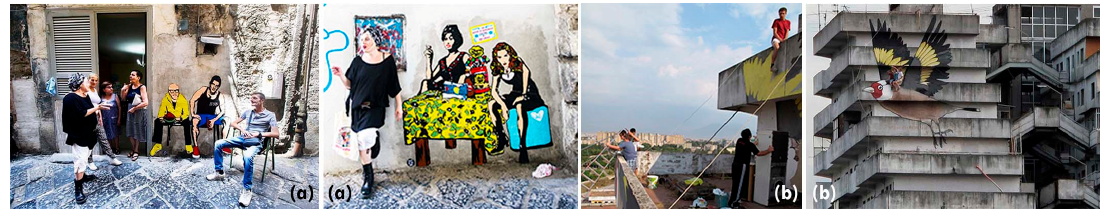
Figure 3. ( a ) Vascio Art by Roxy in the Box; ( b ) The Cardillo of Scampia by S. Jung and P. & H. Schweizer.